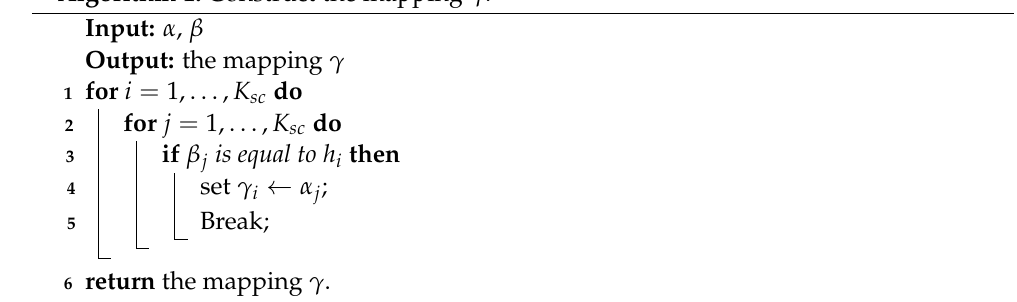
Algorithm 1: Construct the mapping γ